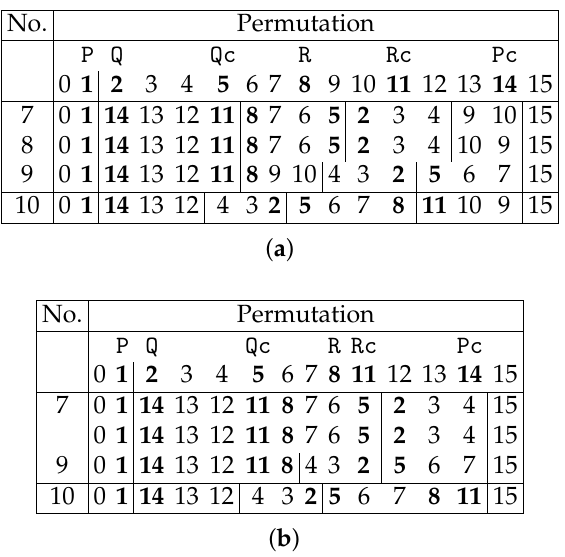
Table 6 contains the four reasonable permutations for case PQ → Qc → R → Rc → Pc . Table 6. Possible 5-opt operations based on a 16-points example if the circular order is PQ → Qc → R → Rc → Pc : ( a ) all 16 points exist; ( b ) points 9 and 10 do not exist.